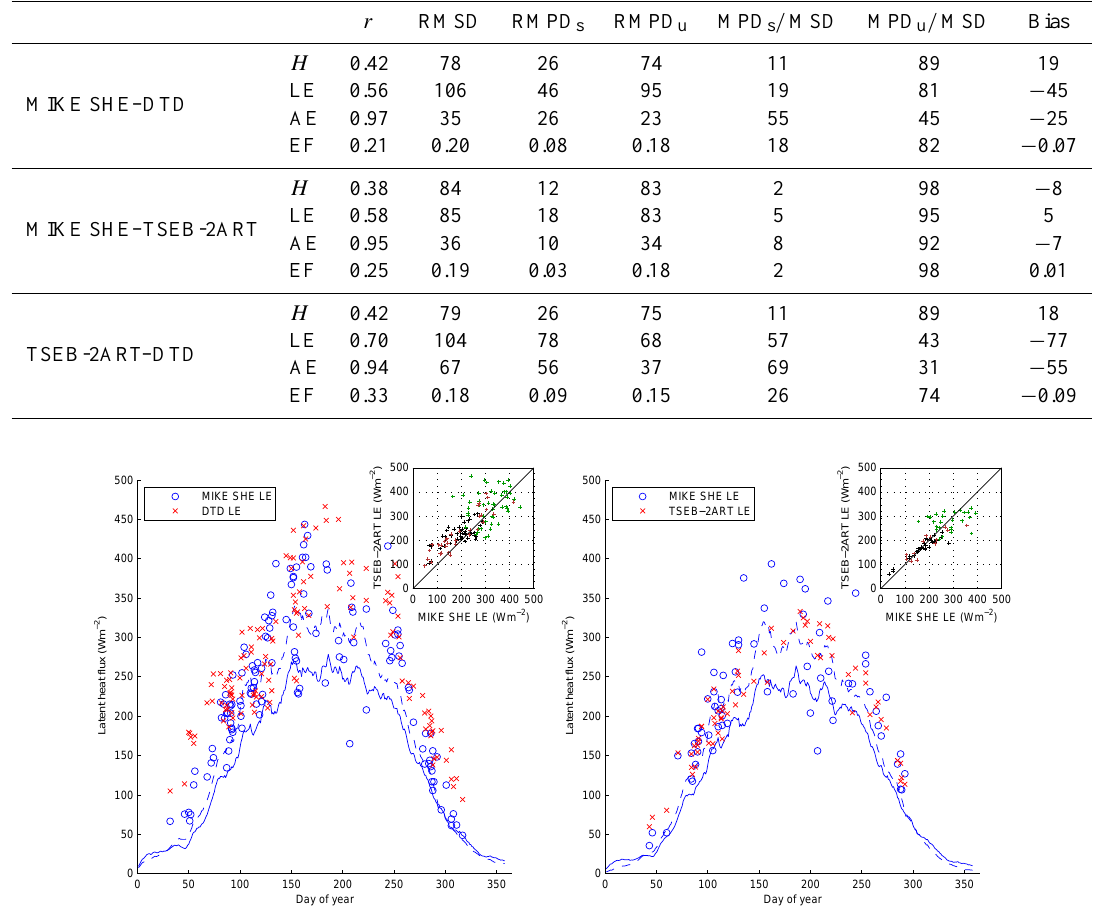
Figure 5. Average catchment-wide latent heat fluxes on the days when at least 70% of non-water and non-urban pixels were modelled by either DTD (left) or TSEB-2ART (right). In the main graph the blue circles represent catchment fluxes modelled by MIKE SHE and the red crosses represent the catchment fluxes modelled by the remote sensing models on the same year and day of year (DOY) and at the same time of day. The figure contains dates from the 8 years under investigation and the blue solid line shows an 8-year averaged whole catchment ET for a particular DOY as modelled by MIKE SHE around the time of Aqua (left) or Envisat (right) overpass. The blue broken line shows potential ET for the same data set estimated using the Priestley–Taylor approach and MIKE SHE AE. The inset image contains a scatterplot of the MIKE SHE and remote sensing fluxes with black indicating fluxes from January to April, green from May to August and brown